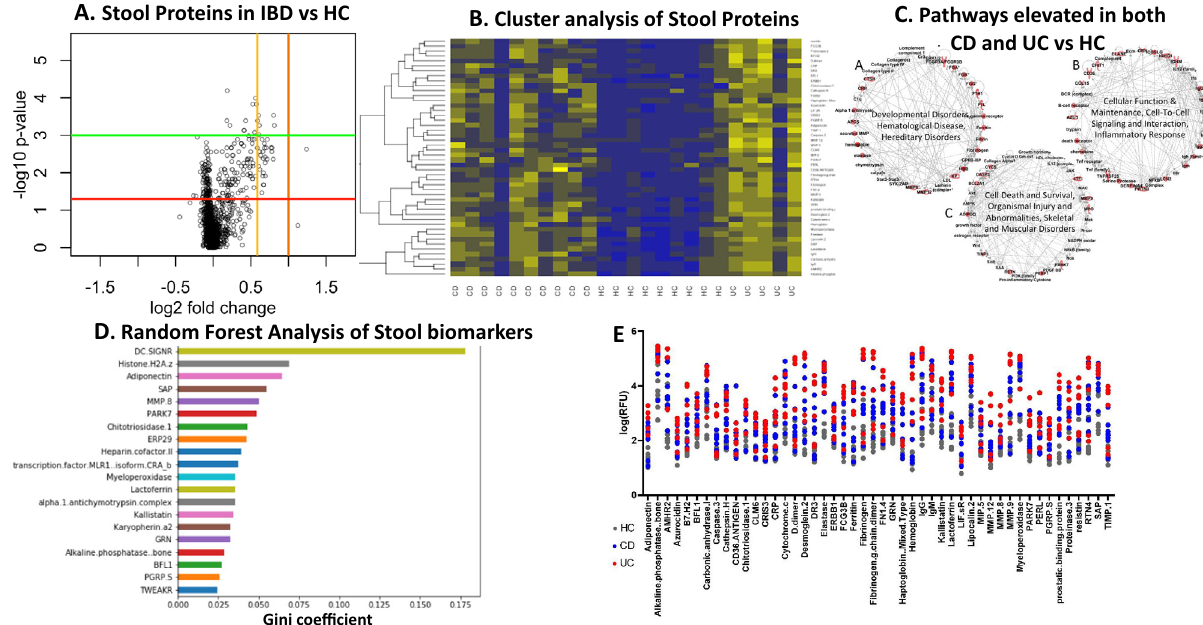
Fig. 2 Aptamer-based screening of pediatric IBD stool samples for 1129 proteins. A A volcano plot representation of results of the aptamer-based screening of 1129 proteins analyzed in 24 pediatric stool samples (10 CD, 5 UC, and 9 healthy controls). Data were log-transformed and analyzed using a two-sided Mann – Whitney U-test to generate statistical p -values and q -values. 48 proteins were found to be elevated ( p < 0.05, fold change > 1.25) in both CD and UC stool when compared to healthy control stool. Each dot represents one of the 1129 proteins and the x -axis shows the log 2 transform of the fold change whereas the y -axis shows the − log 10 transform of the p -value. Thresholds for fold change are indicated with yellow and orange vertical lines for fold change > 1.5 and fold change > 2 respectively while thresholds for p -value are indicated with horizontal red and green lines for p < 0.05 and p < 0.01 respectively. B A heatmap representation of the results of the aptamer-based screen showing the 48 proteins ( p < 0.05, fold change > 1.25) elevated in IBD stool. Proteins that are above the mean value (for each biomarker) are yellow, while those below the mean are blue. C Ingenuity pathway analysis depicts proteins that were signi fi cantly elevated in the stools of both CD and UC patients when compared to healthy control stool, and the functional pathways they belong to molecules elevated in IBD stool when compared to healthy control stool are shaded red. Documented and putative interactions between the displayed molecules are indicated by solid and dashed arrows, respectively. D Random forest classi fi cation analysis identi fi cation of the 20 most discriminatory stool proteins with the largest impact on distinguishing IBD subjects from healthy controls, ordered by their GINI coef fi cient. E The top 48 proteins (ranked in order of fold change for IBD versus healthy controls) that were signi fi cantly elevated in both CD and UC stool when compared to healthy control stool are shown as a dot plot where CD, UC, and healthy control subjects are shown using blue, red, and gray dots, respectively. Of note, 3 of these 48 stool proteins also survived multiple testing corrections, with q -values <